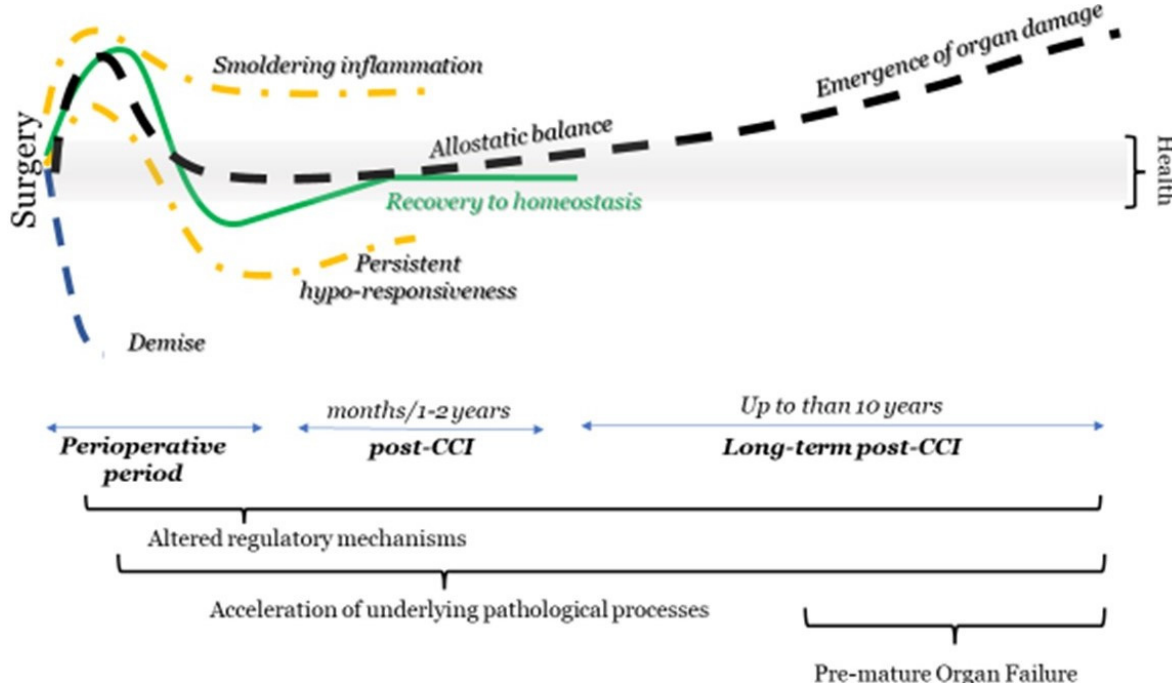
Figure 2. Presurgical stress can trigger different trajectories among patients, including maladaptive allostasis balance leading to long-term consequences.